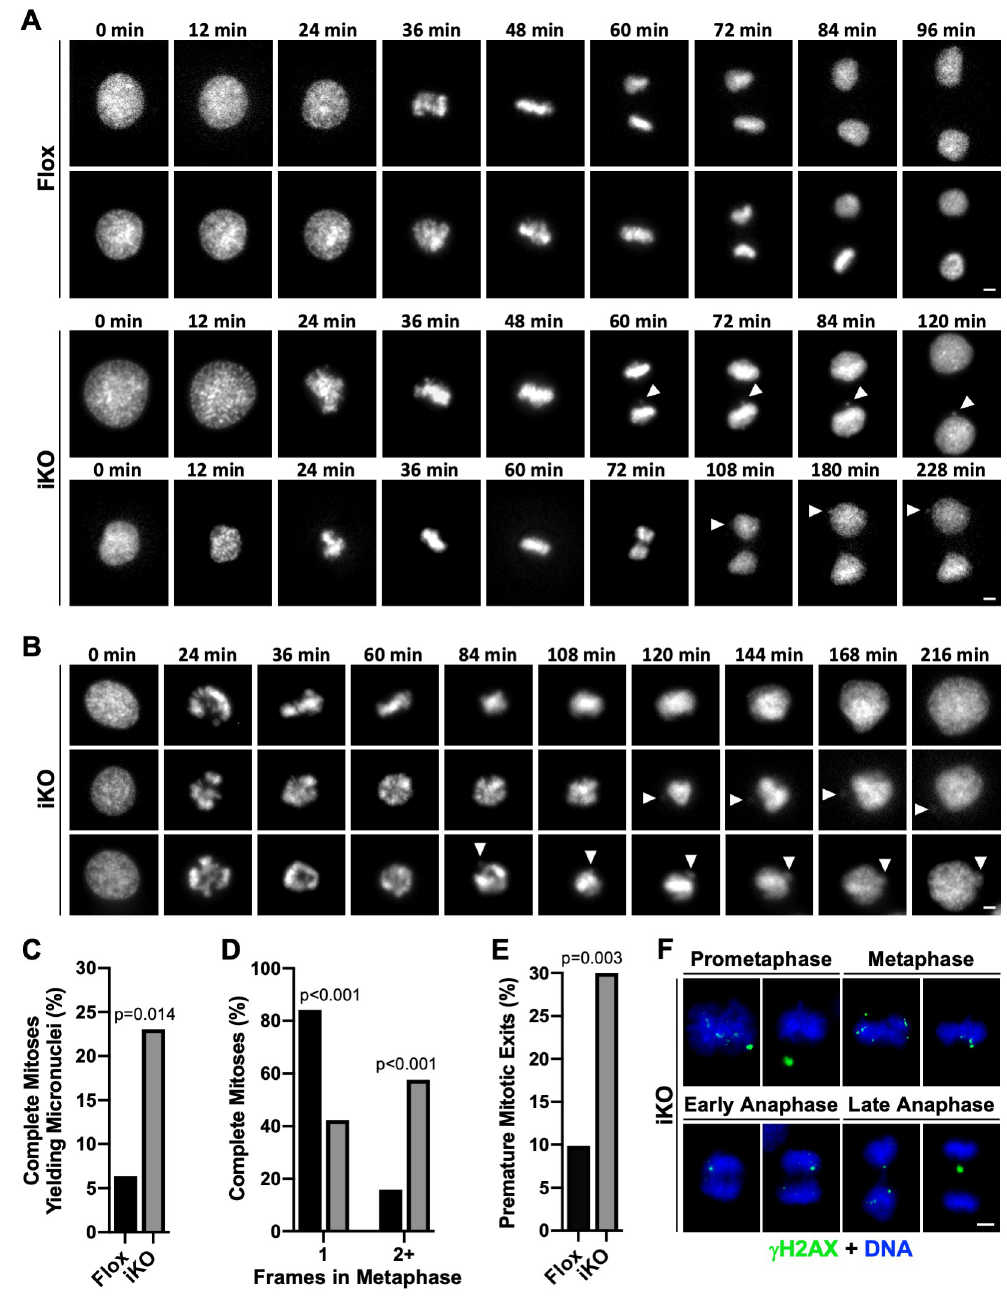
Fig 5. Micronuclei form in ArpC2 iKO cells due to chromatin segregation errors and premature mitotic exits. (A-B) Live H2B-GFP-expressing mouse fibroblasts were imaged every 12min from 1-2d following DMSO (Flox) or 4-OHT (iKO) exposure. Panel A shows completed mitoses, while panel B shows iKO cells exiting mitosis prematurely. Arrowheads in the final 3–6 frames point to micronuclei biogenesis events. Scale bars, 5 μ m. (C) The % of completed mitoses yielding micronuclei was calculated by dividing the number of mitoses yielding at least one micronucleus by the total number of completed mitoses captured during live imaging (Flox n = 63; iKO n = 52; pooled from 13 Flox and 22 iKO experiments). (D) All completed mitoses of Flox and iKO cells were binned into categories based on the number of timepoints observed in metaphase. Black and grey bars represent Flox and iKO data, respectively. (E) The % of premature mitotic exits was calculated by dividing the number of cells that entered prophase and returned to interphase without completing anaphase by the total number of cells that entered prophase (Flox n = 71; iKO n = 70; pooled from 13 Flox and 22 iKO experiments). 10 of the 70 iKO cells (14.3%) formed micronuclei. (F) iKO cells were fixed and stained with a γ H2AX antibody (green) and DAPI (DNA; blue). Movies for panels A and B appear in Supporting Information (S1–S7